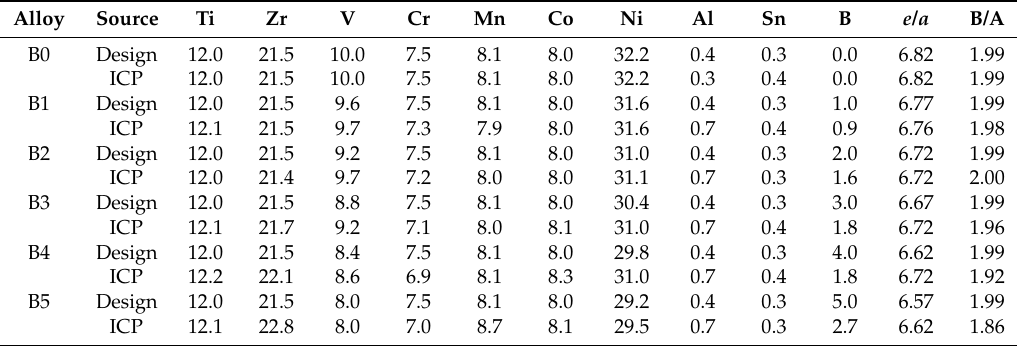
Table 1. Design compositions (in bold ) and inductively coupled plasma (ICP) results in at %. e / a is the average electron density. B/A is the atomic ratio of the B-atoms (elements other than Ti and Zr) to the A-atoms (Ti and